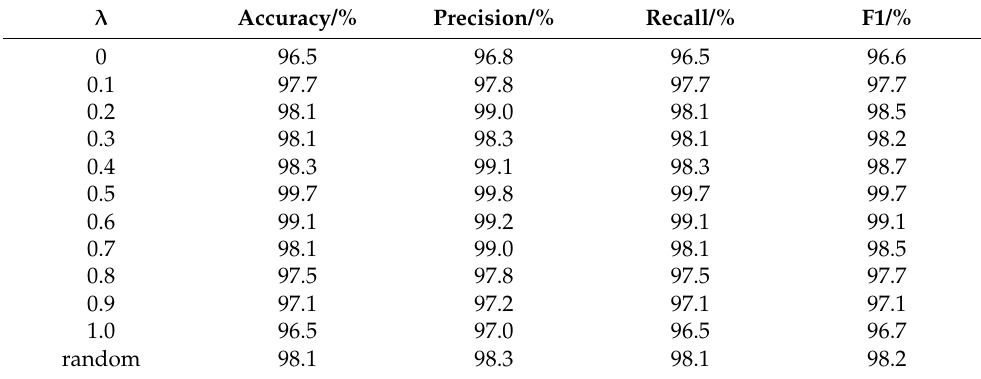
Table 3. Effect of Mixup fusion coefficient on model